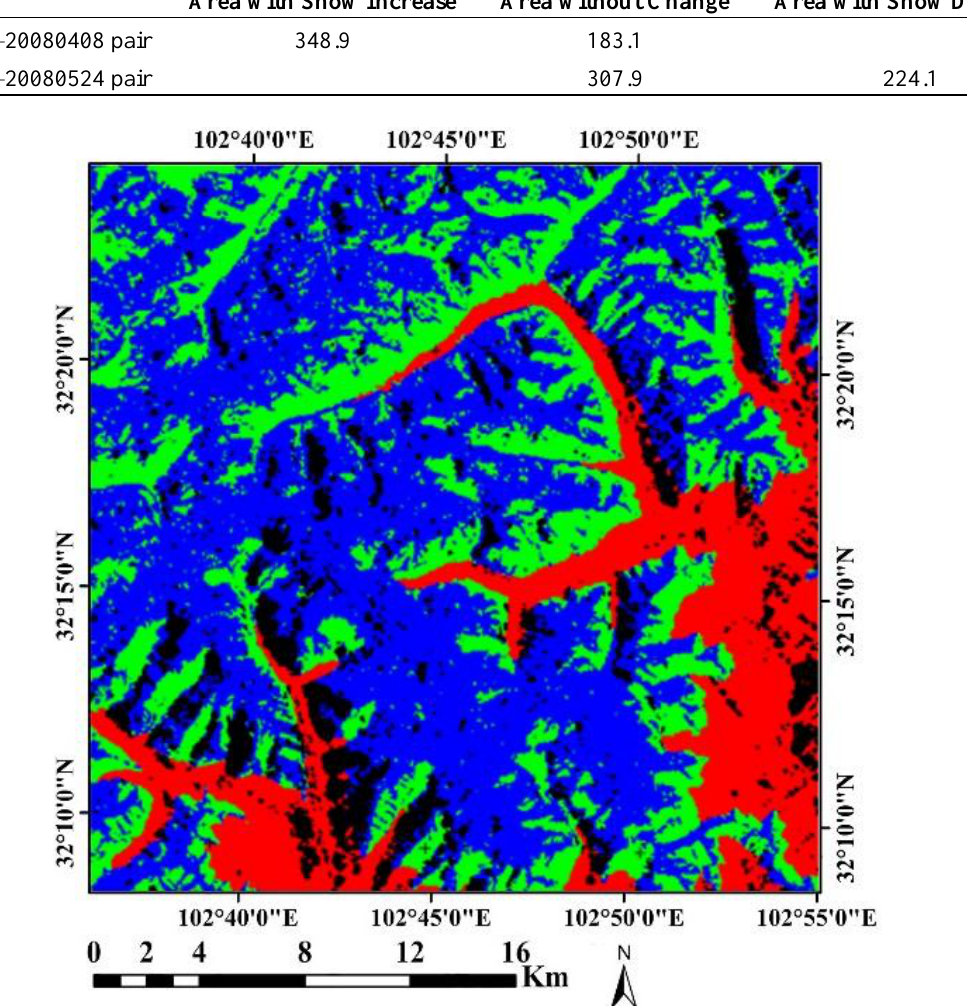
Figure 6. Snow map derived from γ temporal of 20080222–20080408. Areas with snow increase, without snow change, and below tree line were colored in blue, green, and red,